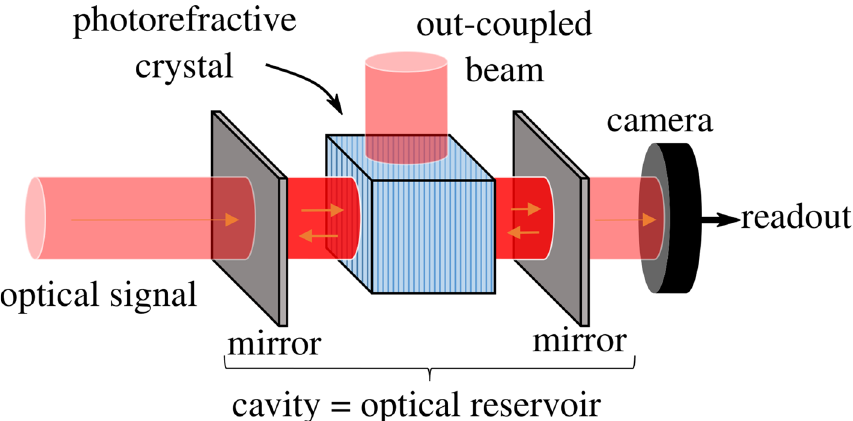
Figure 1. A photorefractive crystal placed in a cavity. Light entering the cavity will interact with the photorefractive crystal such that part of the light will be coupled out of the cavity. Moreover,